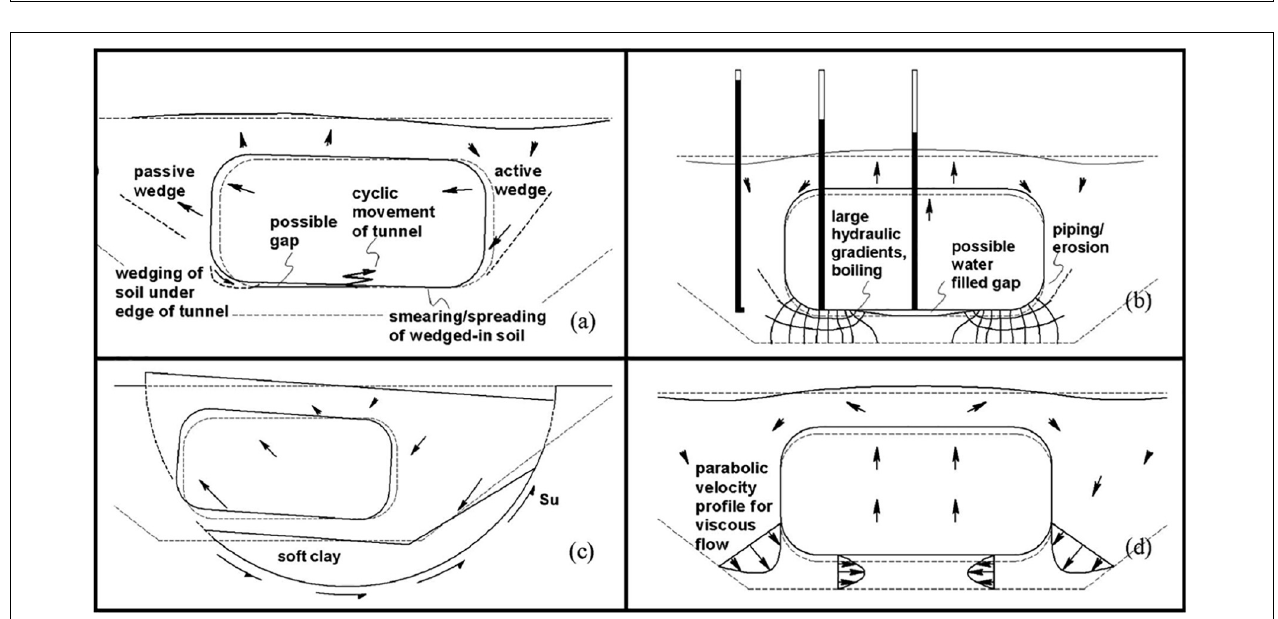
FIGURE 4 | Four uplift mechanisms: (a) ratcheting, (b) pore water migrations, (c) bottom heave, and (d) viscous flow of liquefied soil (Reproduced from Chou et al., 2011 with permission from